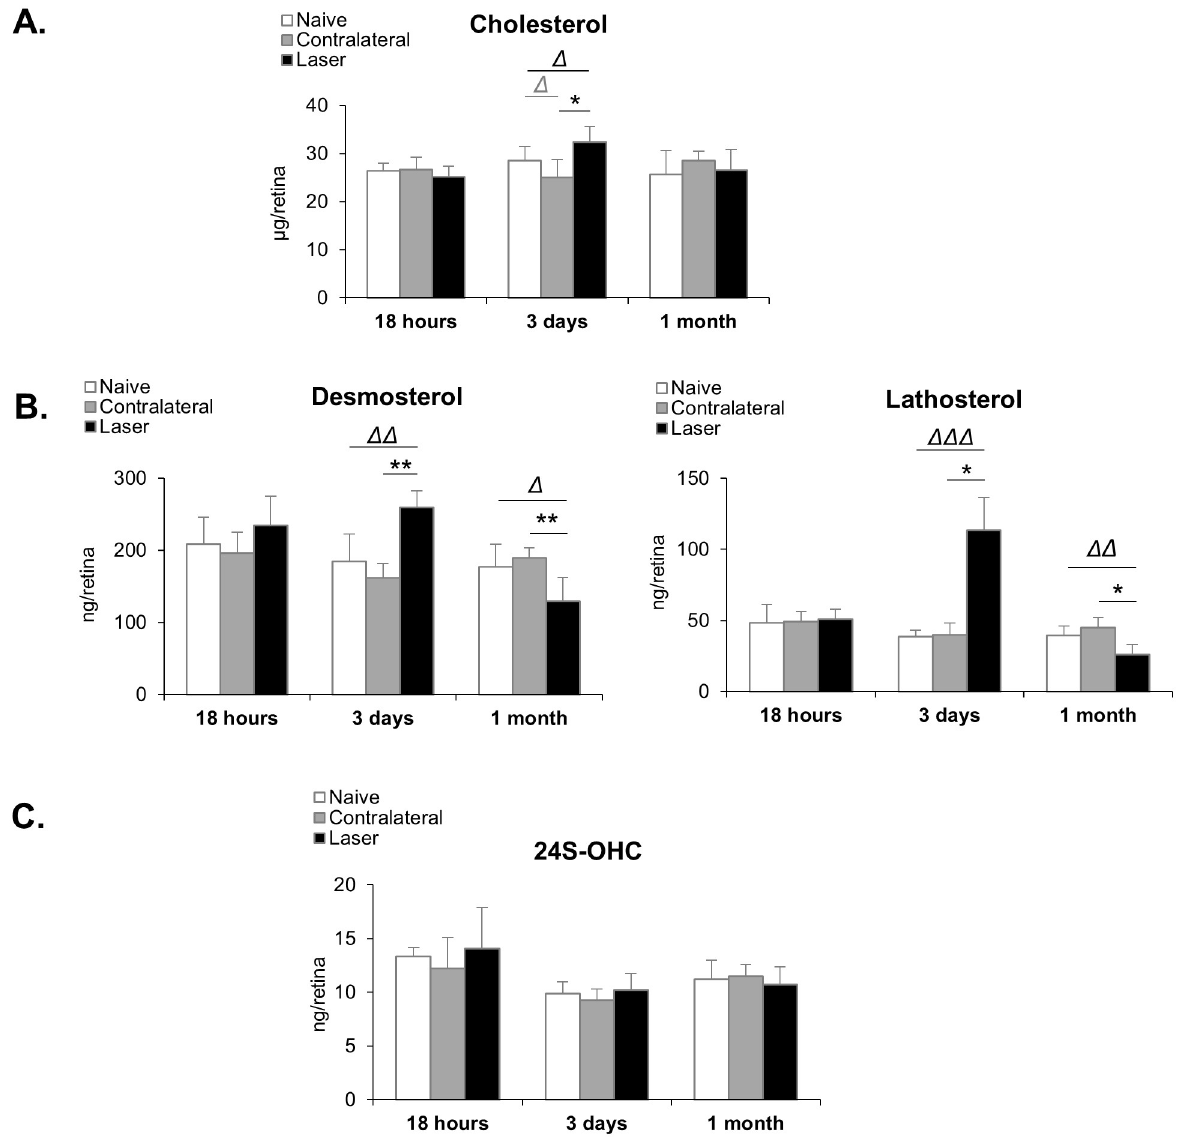
Fig 6. Laser procedure induces a transient increase in cholesterol and cholesterol precursor levels in the retina. (A) Cholesterol was quantified using GC-FID. Cholesterol precursor levels, desmosterol and lathosterol (B) , and levels of 24S-hydroxycholesterol (24S-OHC) (C) were measured using GC-MS. Results are presented as mean ± S.D. Δ p < 0.05, ΔΔ p < 0.01, ΔΔΔ p < 0.001 vs naive (Mann-Whitney test), � p < 0.05, �� p < 0.01 vs contralateral (Wilcoxon matched-pairs signed rank test). n = 7–8 retinas in each